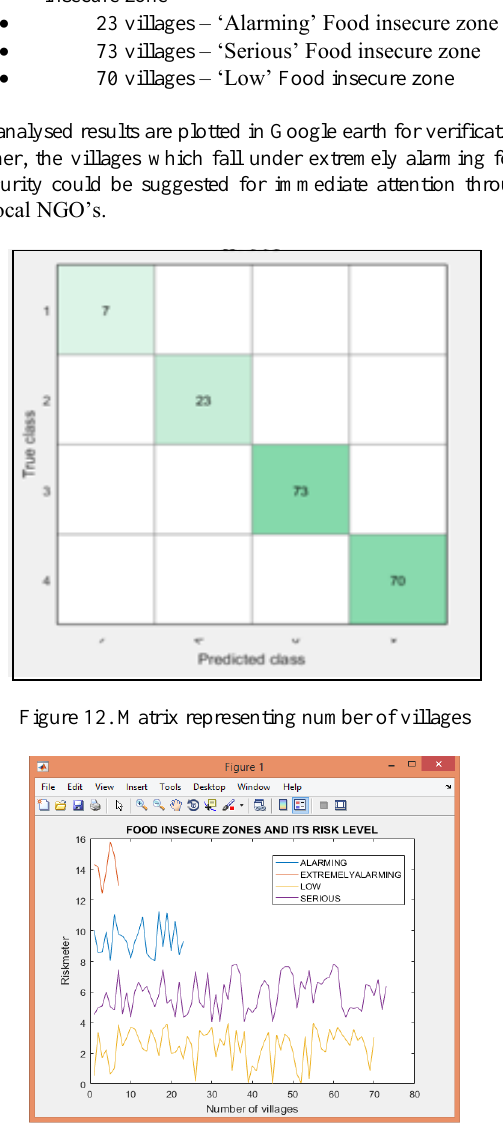
Figure 13. Number of villages with respect to risk metric